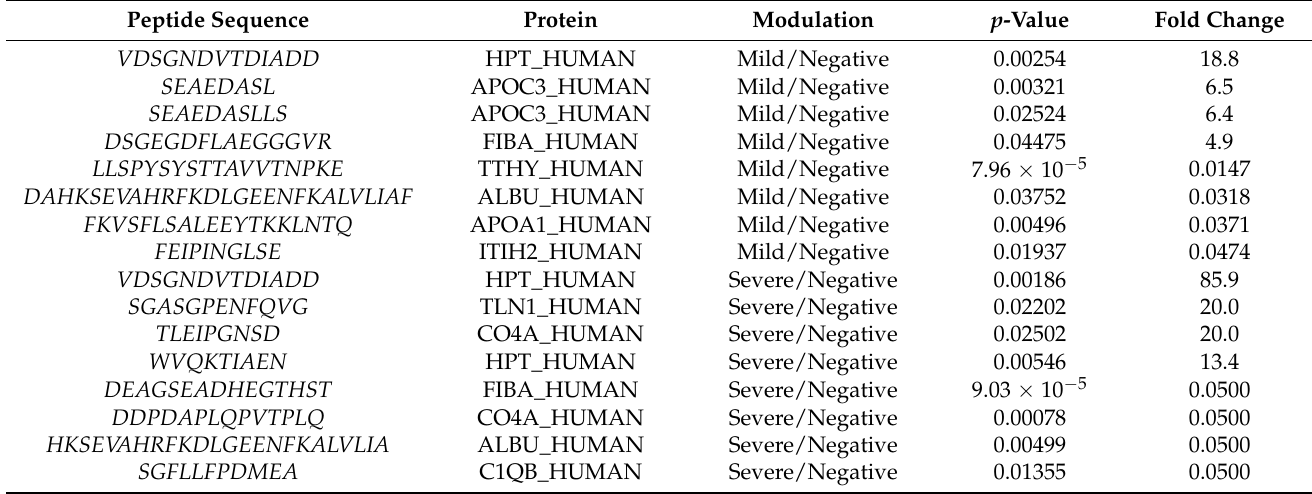
Table 2. List of most modulated peptides in COVID-19 patients (mild and severe) compared to negative controls with their derived protein, p -value, and fold